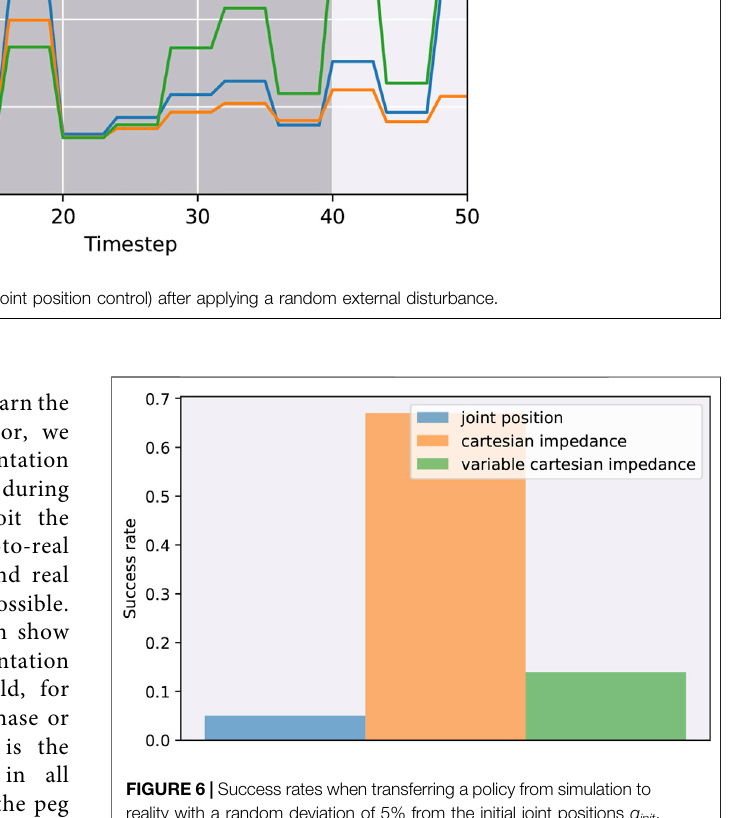
Frontiers in Robotics and AI |